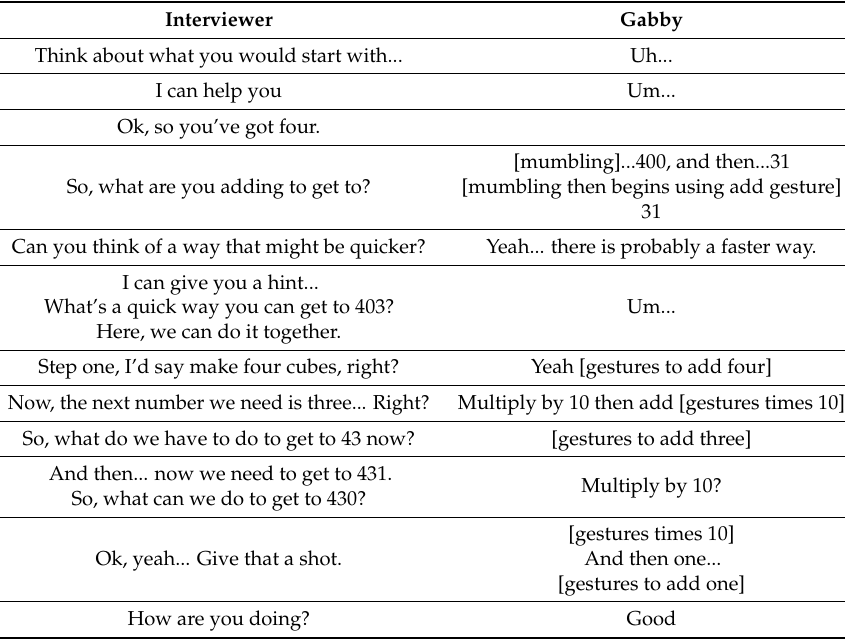
Table 3. C431 dialogue of a student and